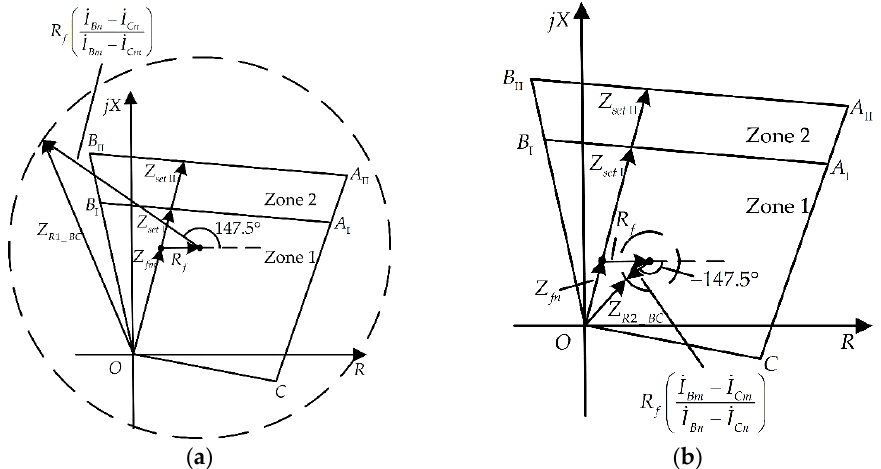
Figure 8. The operating characteristic of BC elements in R1 and R2: ( a ) BC element in R1; ( b ) BC element in R2.